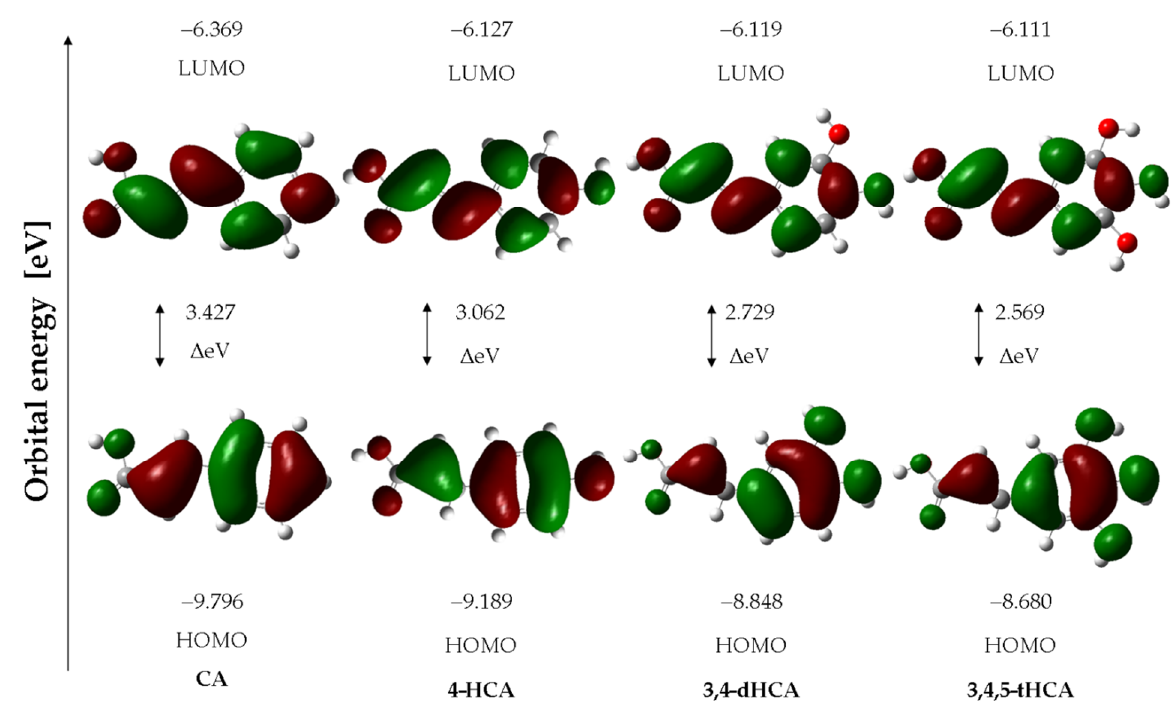
Figure 4. The HOMO/LUMO electron densities in molecules of studied compounds.